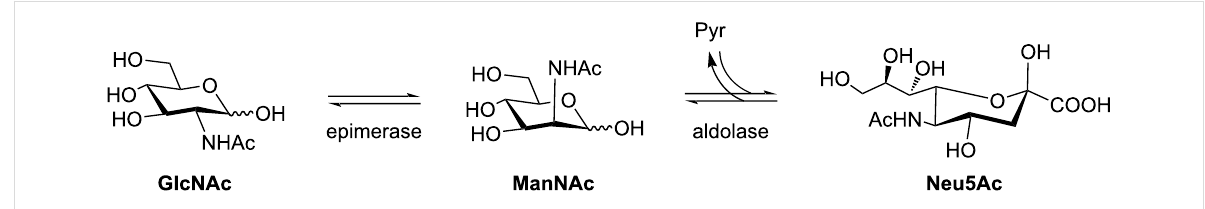
Figure 1: Reaction sequence starting from GlcNAc with ManNAc as an intermediate. Pyr is added in the second step, forming Neu5Ac. The reaction steps are catalyzed by an epimerase (EC 5.1.3.8) and an aldolase (EC 4.1.3.3),